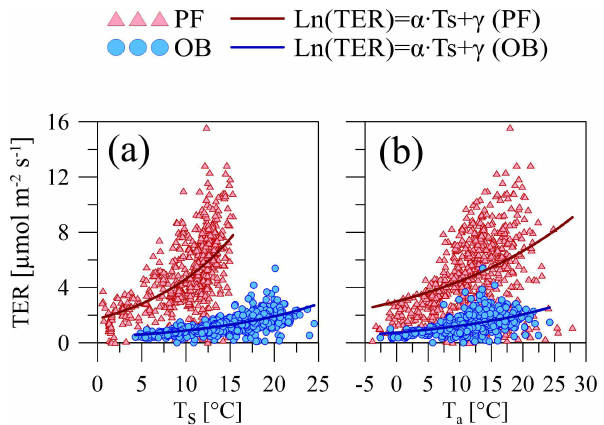
Figure 4. Relationship between the mean nighttime ecosystem res- piration (TER) and (a) soil ( T s ) and (b) air temperature ( T a ) at the paludified forest (PF) and ombrotrophic bog (OB) sites in the period 12 April–11 October 2015–2020 (approximated using the Q 10 function; see Eq. 1).